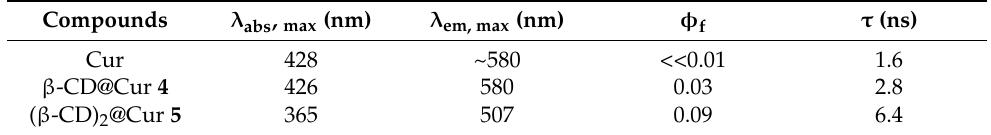
Table 1. Photophysical properties of Cur and nanoconjugates 4 and 5 . Compounds λ abs , max (nm) λ em, max (nm) φ f τ (ns) Cur 428 ~580 <<0.01